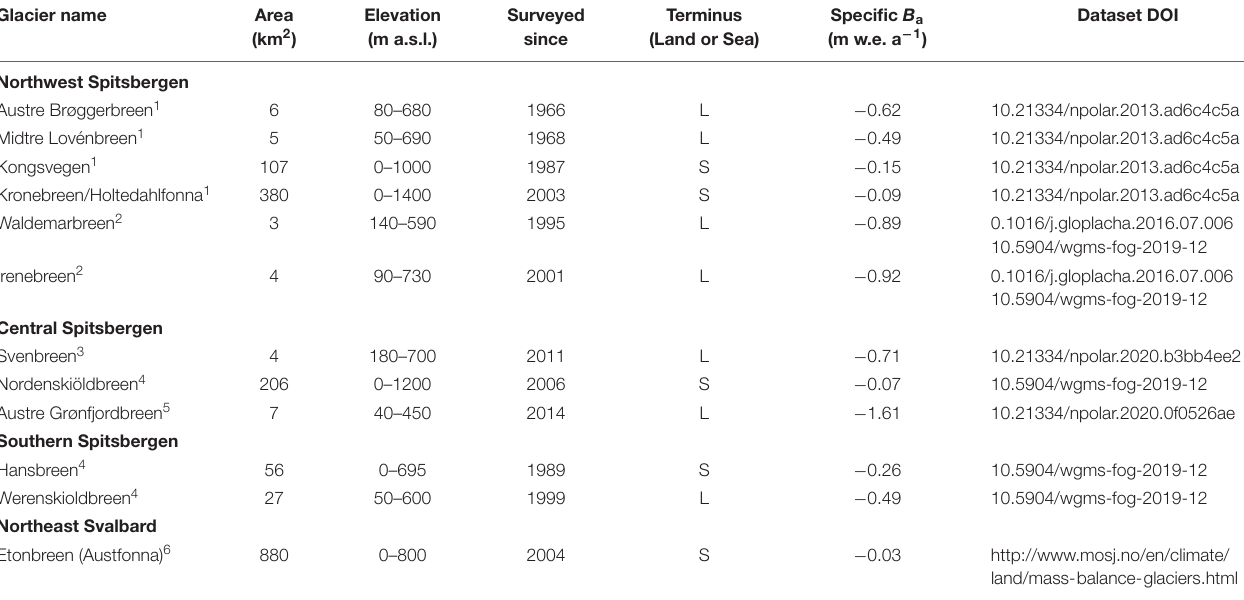
TABLE 1 | List of currently surveyed glaciers with records of 5 years or longer, and their characteristics. Annual glacier mass balance B a refers to the temporal average over 2000–2019. Glacier